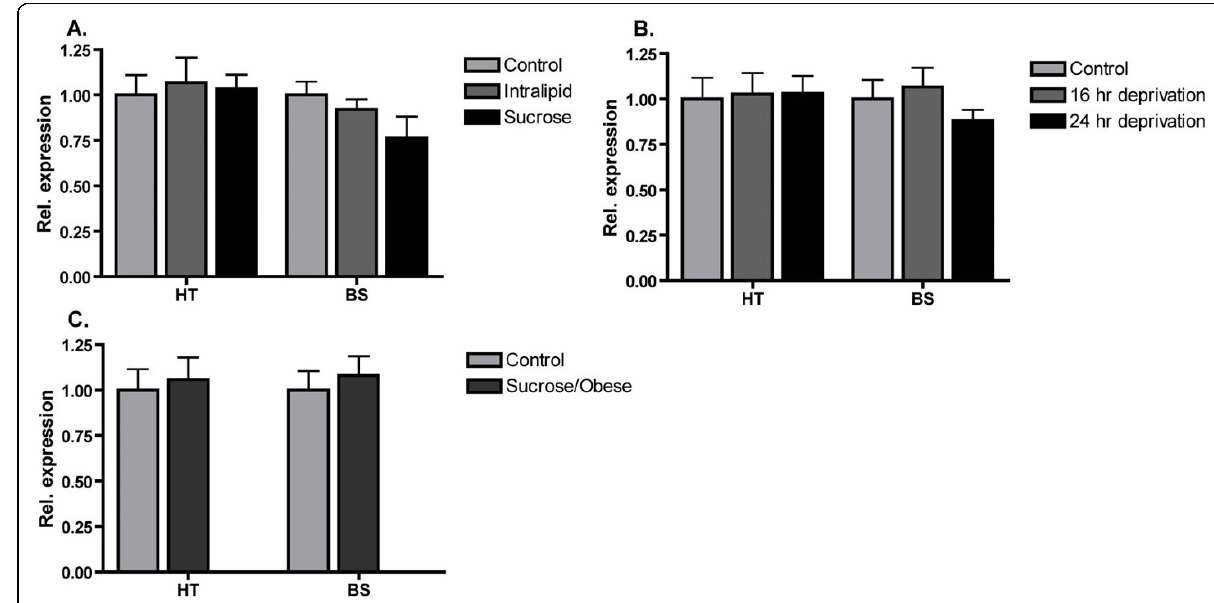
Figure 6 TMEM18 hypothalamic and brainstem mRNA expression in three feeding-related mouse models . mRNA expression relative to the control group (error bars represent SEM) in the hypothalamus (HT) and brainstem (BS) for: A . 48-h consumption of palatable sucrose or Intralipd, B . 16- and 24-h food deprivation and C . Increased body weight after 3-week exposure to sucrose. No significant changes in TMEM18 mRNA expression were found using a one-way ANOVA in any of the experiments.